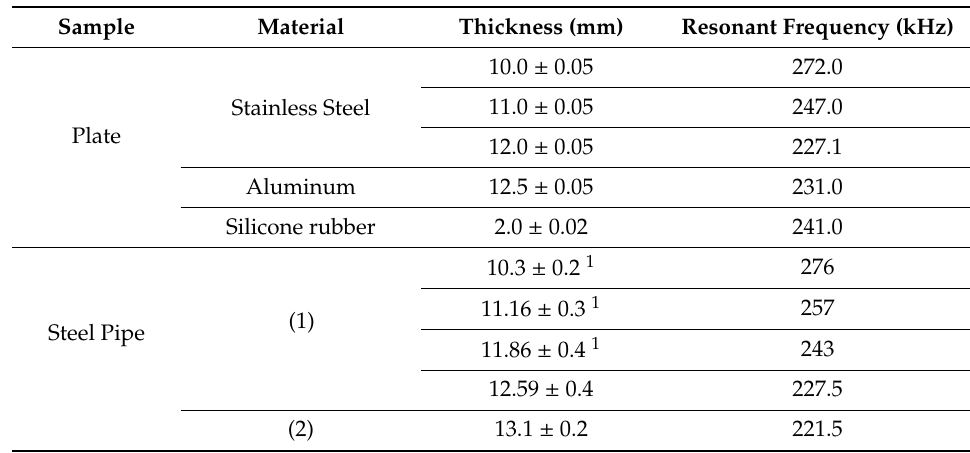
Figure 4. Through-transmission in the 11 mm-thick stainless steel plate. Top: signal in the time domain. Center: FFT modulus of the signal within window (1). Bottom: FFT modulus of the signal within window (2). Table 3. Through-transmission resonant